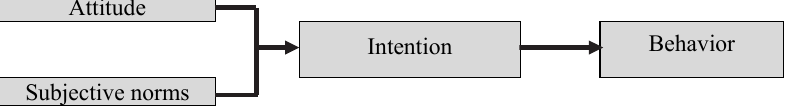
Intention Behavior